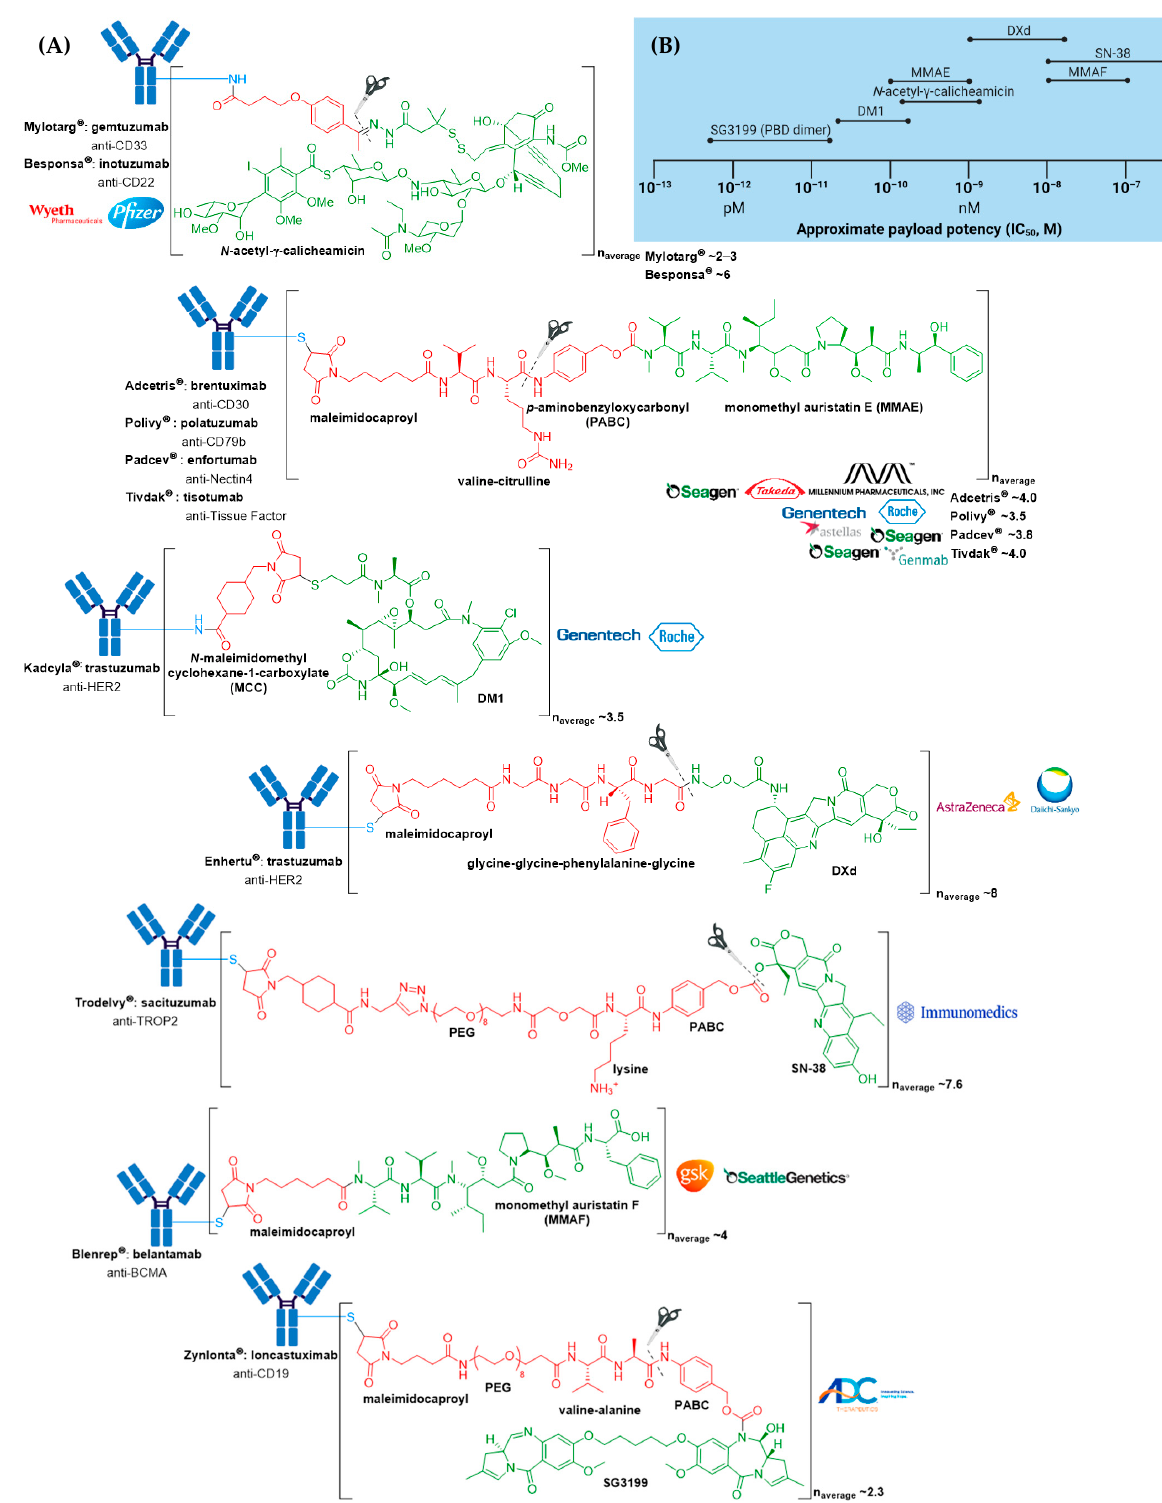
Figure 2. ( A ) Structures of FDA approved antibody-drug conjugates (ADCs). The antibody is shown in blue, and chemical structures for linker and payload are in red and green, respectively. Scissors indicate the cleavage site (if applicable). Pharmaceutical makers and drug-to-antibody ratio for each ADC is indicated. ( B ) Comparison of approximate payload potency ranges (Created with BioRender.com, accessed September